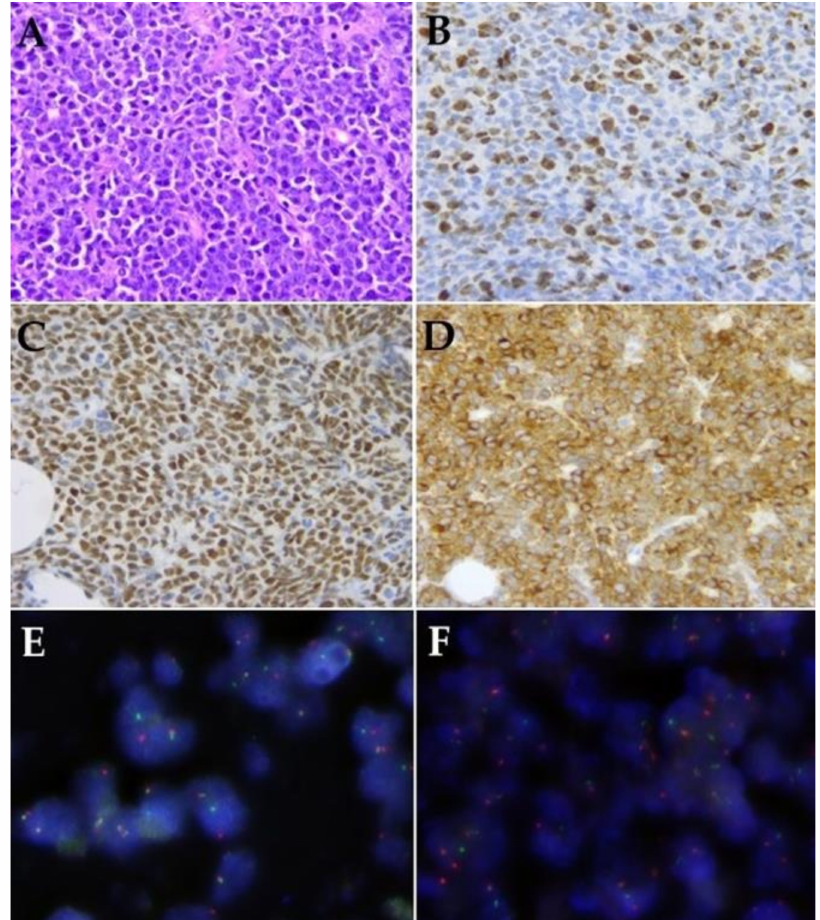
Figure 2. Histological (40 × ), immunohistochemical (IHC) (40 × ), and FISH (100x) features one of the double-hit cases (Case 18). ( A ): Conventional histological (H&E) record. ( B ): Ki-67 IHC. ( C ): MYC IHC. ( D ): BCL2 IHC. ( E ): MYC FISH. ( F ): BCL2